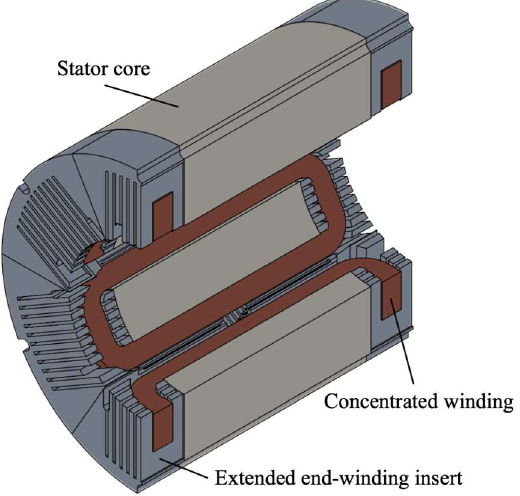
Figure 7. Cross section of a machine stator with extended end-winding insert [31].